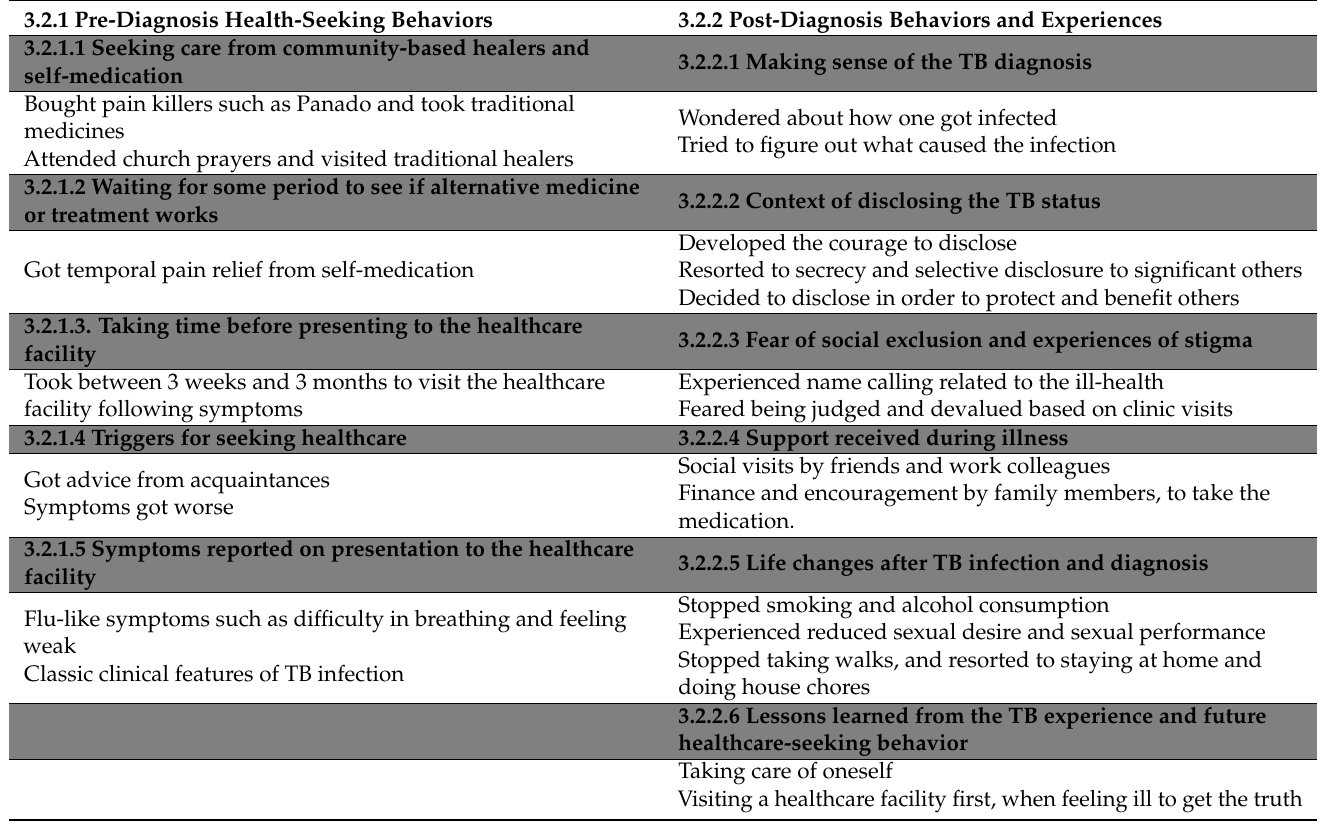
Table 3. Themes and